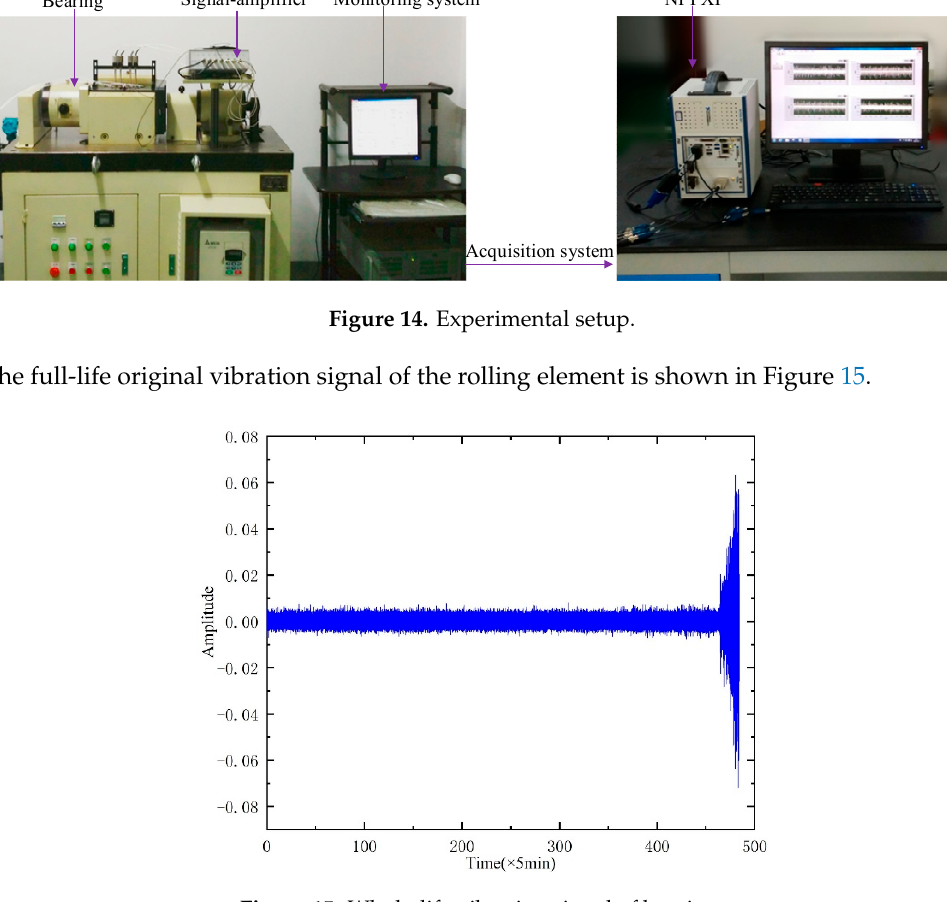
Figure 15. Whole-life vibration signal of bearing.